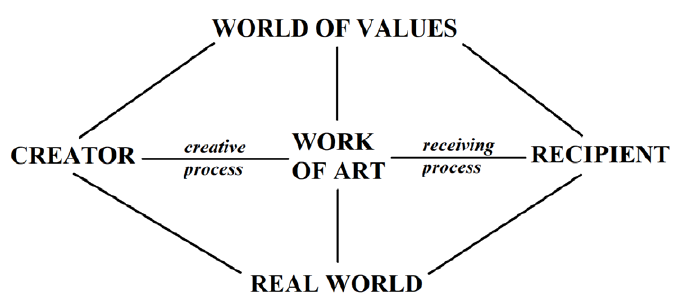
Figure 1. Aesthetic situation (source: created by